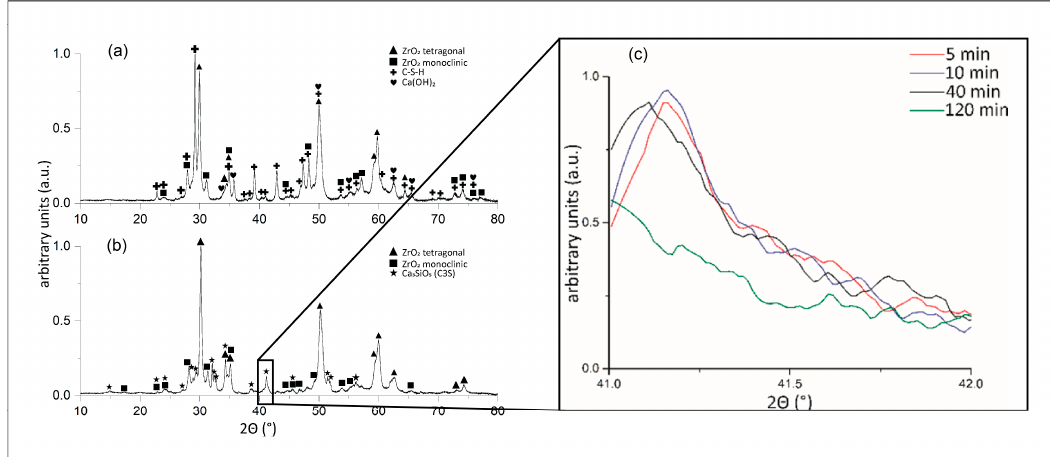
Figure 6. XRD di ff ractograms of the RS+ CSH cement: ( a ) as received; and ( b ) after hydration. ( c ) In